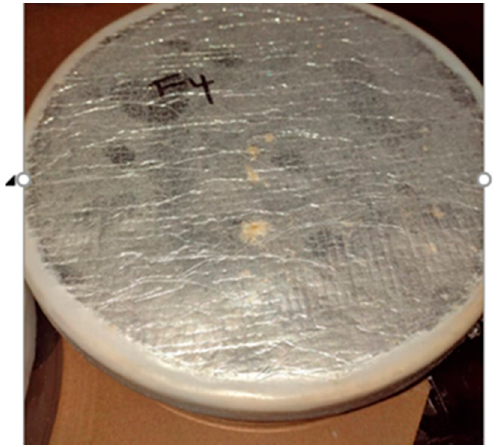
Figure 4. Mould growth on specimen E.